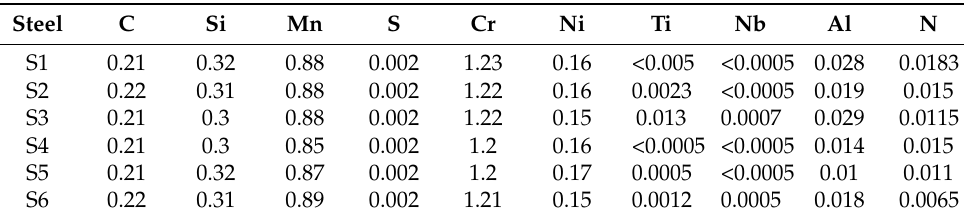
Table 1. Chemical compositions of the experimental steels (wt.%).